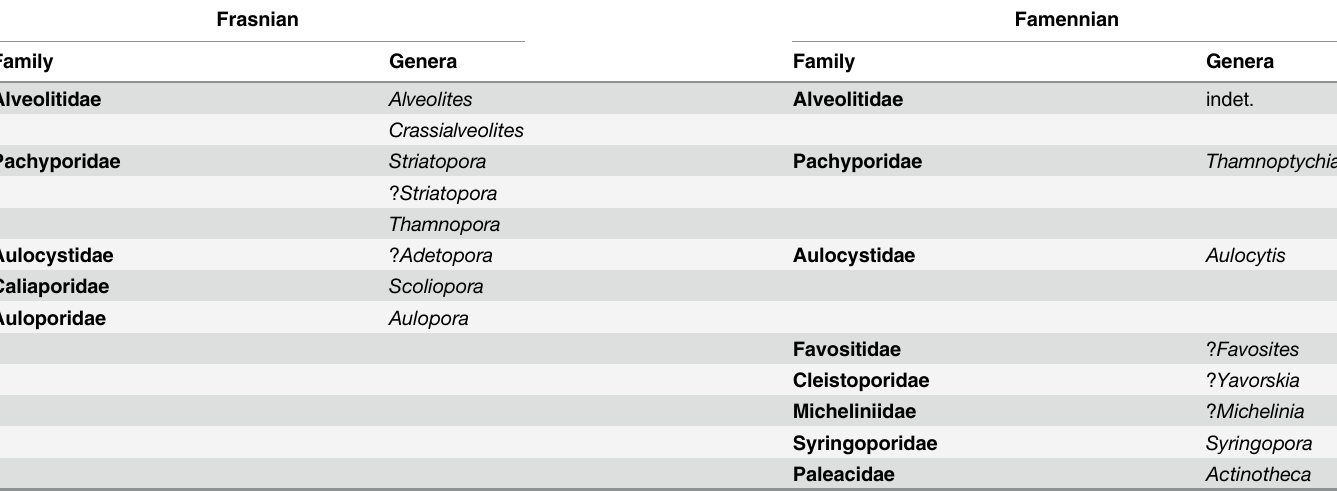
Table 5. Distribution of tabulate faunas in the Devonian of Kowala